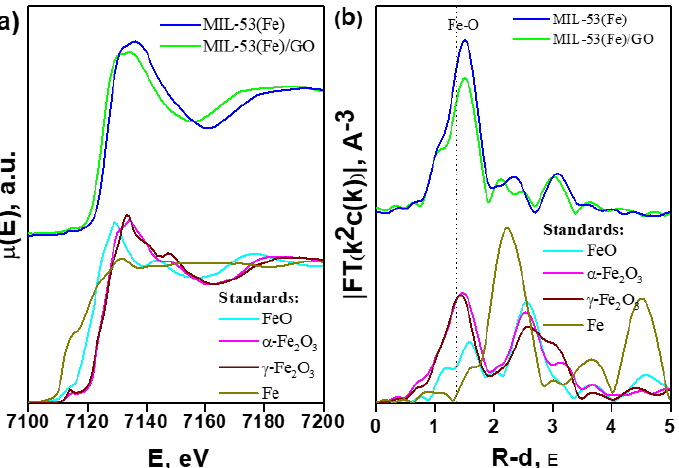
Figure 11. XANES ( a ) and EXAFS ( b ) on the Fe K-edge data for MIL-53(Fe)/GO and MIL-53(Fe) samples along with data for iron foil and iron oxides standards.